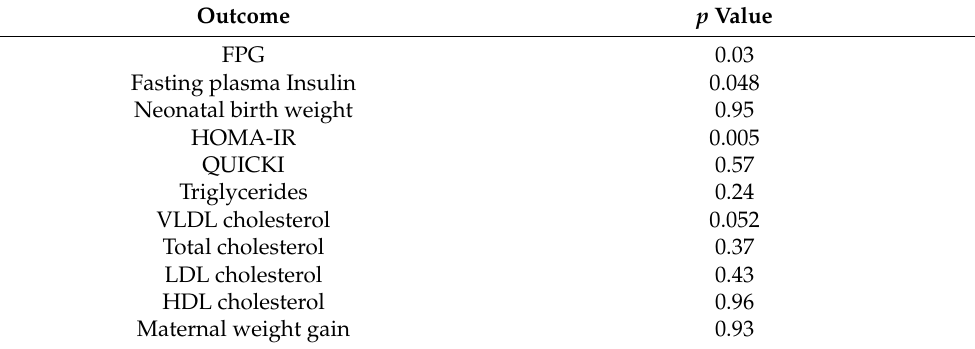
Table 2. Egger’s test for asymmetry.